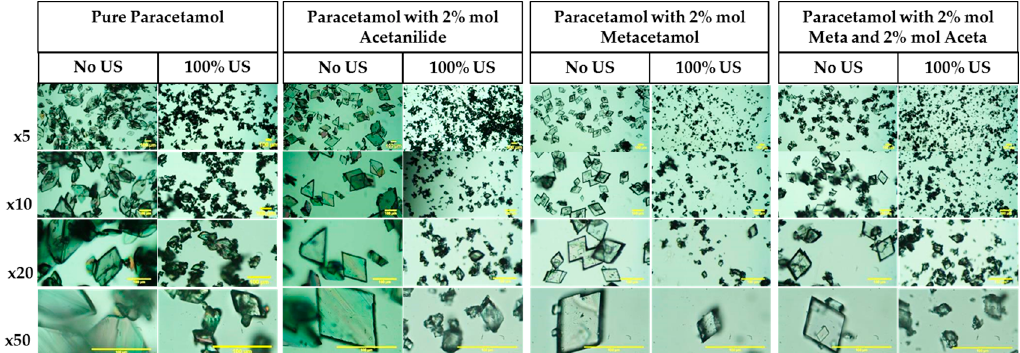
Figure 8. Optical microscopy images of recrystallized paracetamol crystal habit (from the left to the right) for the case of paracetamol with addition of 2% mol acetanilide with no US and 100% US power, paracetamol with addition of 2% mol metacetamol with no US and 100% US power, paracetamol with addition of 2% mol metacetamol and 2% mol acetanilide with no US and 100% US power. Scale bar: 100 µm.